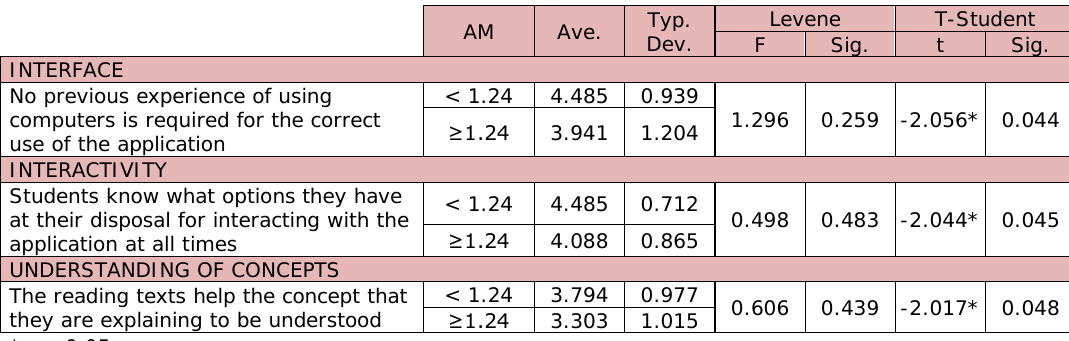
Table 9. “Independent-samples t-Student test according to